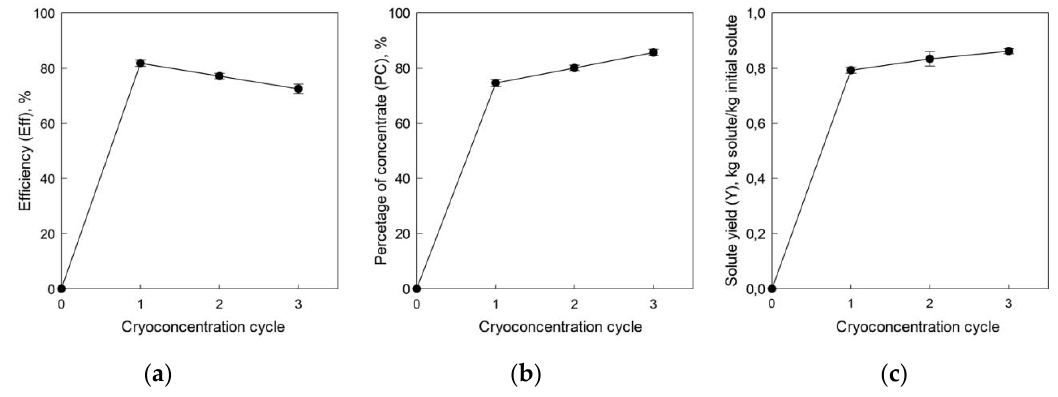
Figure 5. Process parameters: ( a ) efficiency; ( b ) percentage of concentrate; ( c ) solute yield.